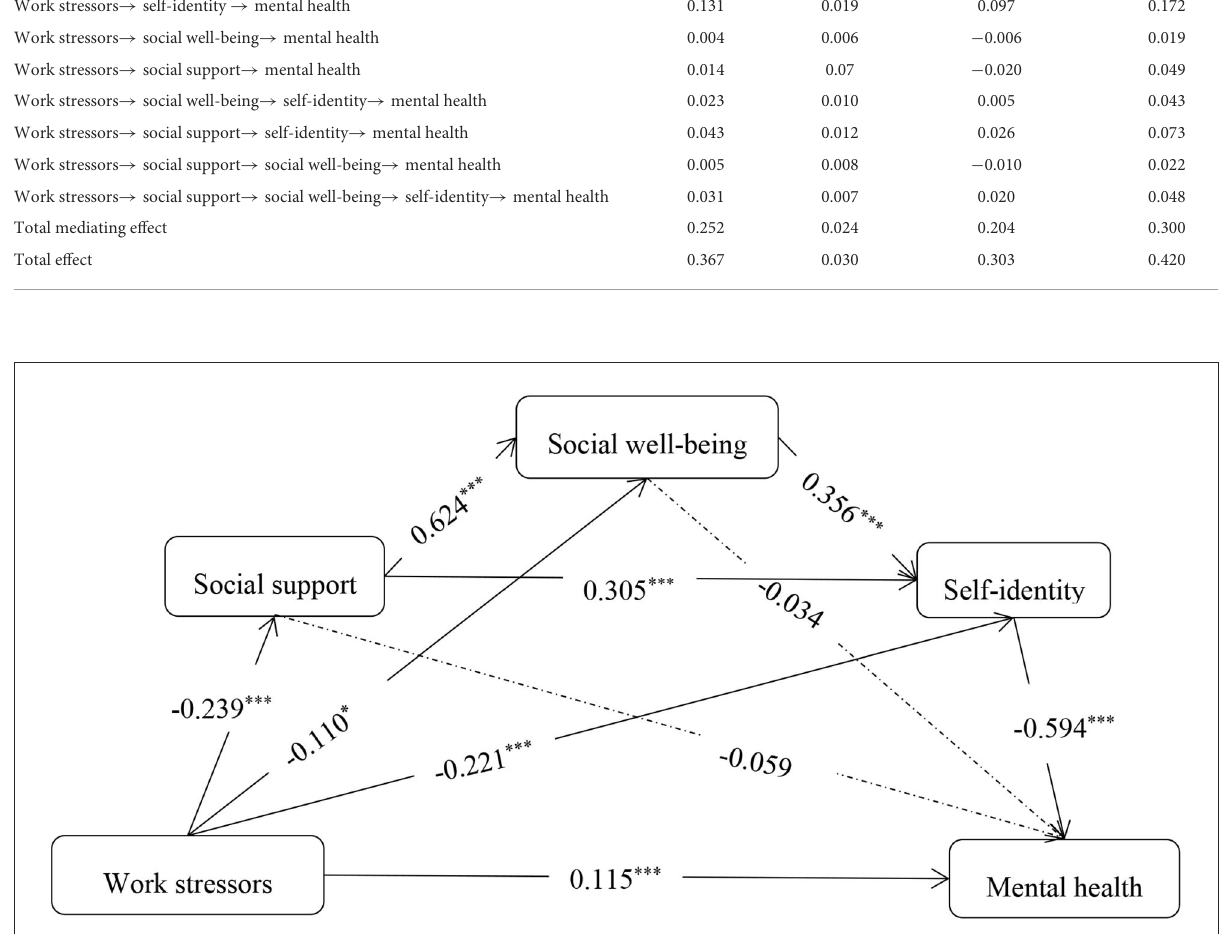
FIGURE3 The mediation model of college students’ work stressors on mental health. * p < 0.05, *** p <